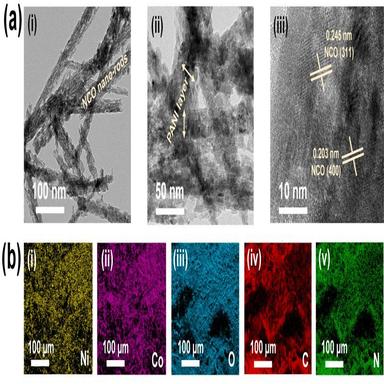
(a) (i, ii) TEM images of NCO/PVP/PANI1.5 composite, and (a) (iii) high-resolution TEM image of NCO/PVP/PANI1.5 composite. (b) EDX elemental mapping images of Ni, Co, O, C, and N, respectively in NCO/PVP/PANI1.5 composite.